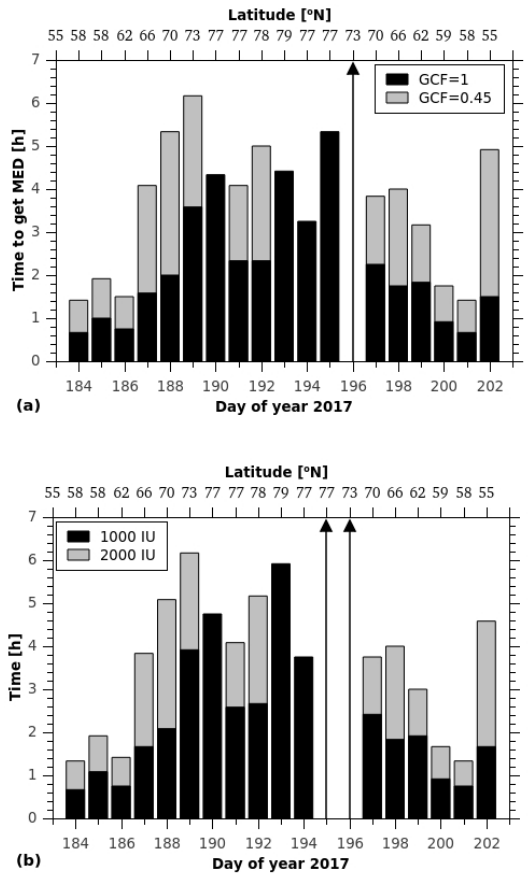
Figure 4. Daily duration of solar exposure for the entire cruise resulting in the ambient (or on vertical plane) erythemal dose of 1 MED 2 ( a ), the personal vitamin D 3 dose equivalent to 1000 IU (or 2000 IU) vitamin D 3 taken orally ( b ). The exposure started with the moment of the first UVI measurements. Arrows for the 195 and 196 day of the year means the duration is longer than 7 h.